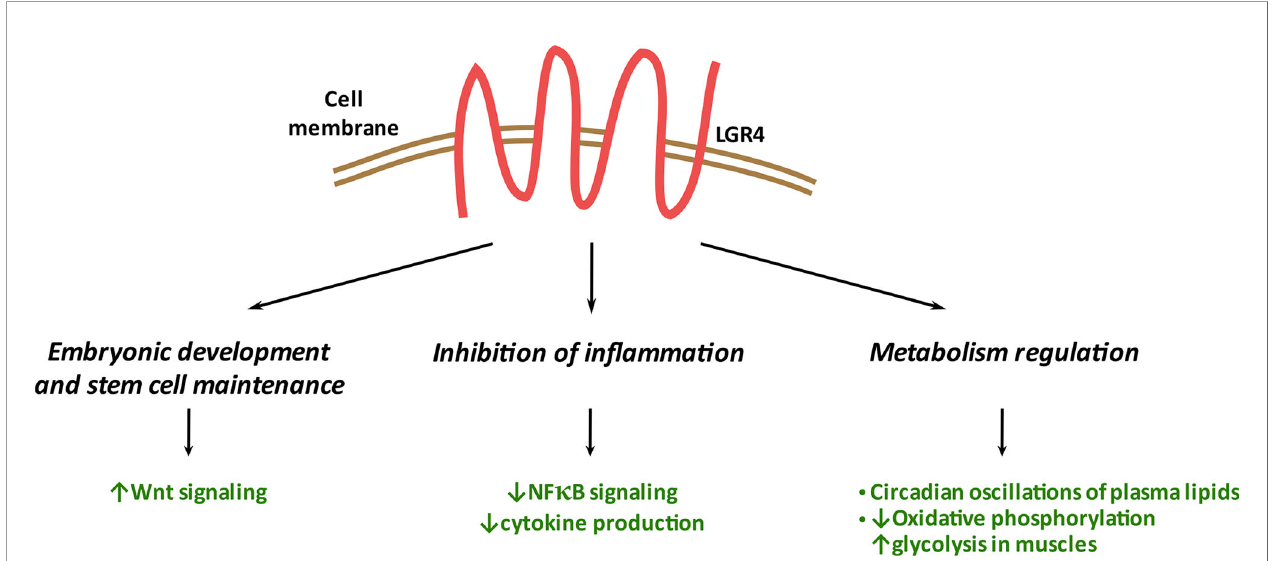
FIGURE 4 | Systemic functions of LGR4. LGR4 plays a signi fi cant role in embryonic development/stem cell maintenance through its binding to RSPO1 and regulation of the WNT signaling pathway. LGR4 reduces in fl ammation in multiple tissues through inhibition of NF k B signaling and cytokine production. LGR4 affects metabolism through multiple mechanisms including circadian clock, oxidative and glycolytic pathways